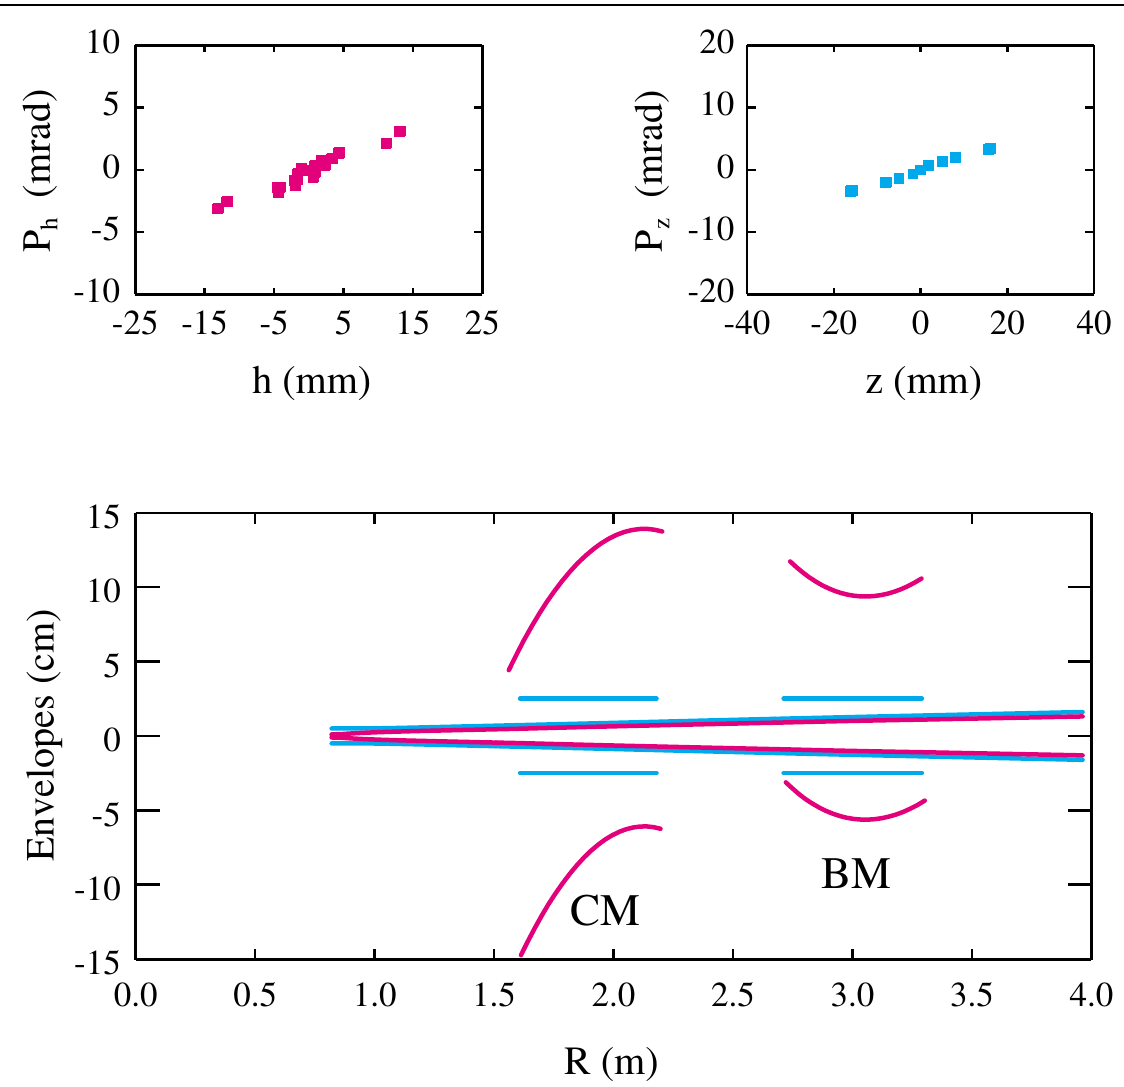
FIG. 7. (Color) Beam emittances and envelopes for K (cid:4) (cid:2) 1 . The beam emittances in the horizontal and vertical directions, represented in the upper left and upper right graphs, respectively, correspond to R (cid:4) 4 m , i.e., to the position along the high-energy and z , P are the spatial and momentum coordinates of a test transport line displaced 1 m from the transport line beginning. h , P h z ion with respect to the central test ion in the horizontal and vertical directions, respectively. The lower graph gives the radial dependence of the horizontal (magenta) and vertical (cyan) beam envelopes and apertures of the combined and bending magnets using the central ion trajectory as a referent zero axis. The central ion trajectory is confined to the median plane; therefore, for the vertical envelope and apertures the graph’s zero axis corresponds to z (cid:4) 0 , and the magnets’ apertures are not distorted. The distortion of the horizontal magnet aperture is the consequence of the strong bending of the beam central trajectory inside the magnet. The presented emittances and envelopes correspond to the beam of protons obtained from H (cid:2) ions accelerated to 65 MeV. (cid:4) 0 : 564 58 T , G (cid:4) 0 T = m , and The combined and bending magnet parameters used in the beam dynamics simulation are B CM (cid:4) (cid:2) 0 : 474 77 T . The horizontal as well as the vertical emittance matches the required transport line acceptance. In the lower B BM graph, the coordinate of the center of the combined magnet entrance is (cid:14) (cid:2) 5 cm and not 0 cm because the beam does not enter the (cid:4) 6 (cid:1) , but through the point with (cid:6) (cid:4) 4 (cid:1) combined magnet through its center positioned at (cid:6) e e